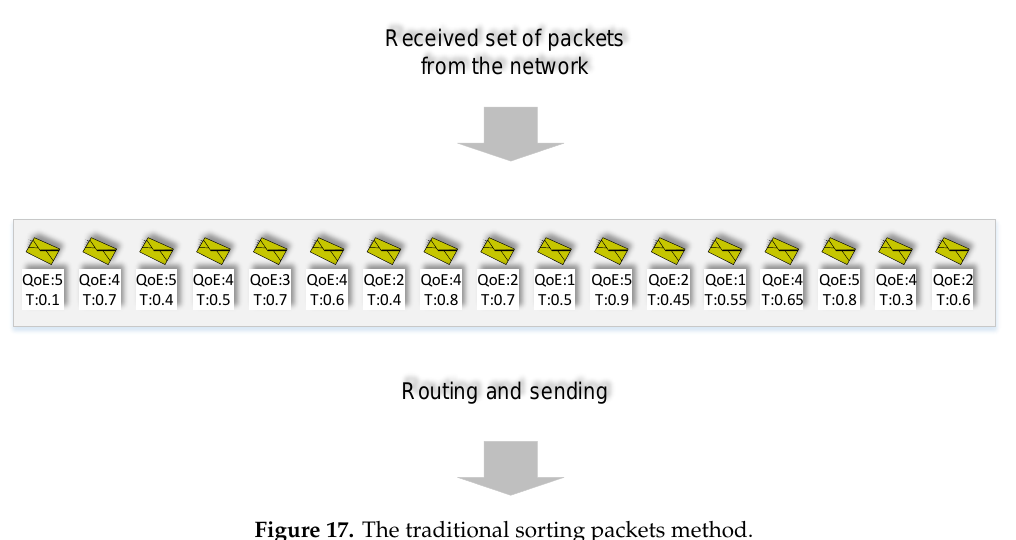
Figure 17. The traditional sorting packets method.